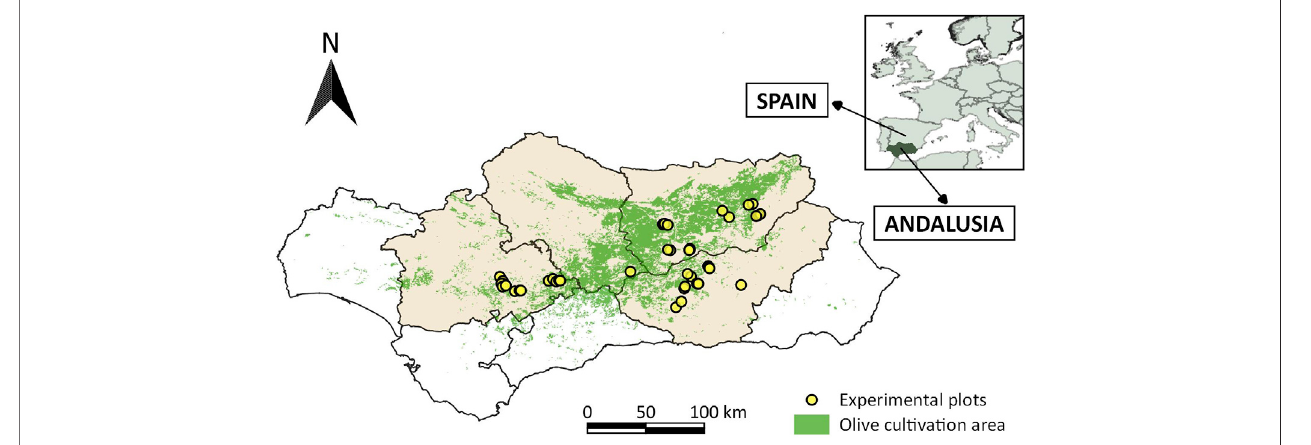
FIGURE 1 | Location of the selected olive groves in